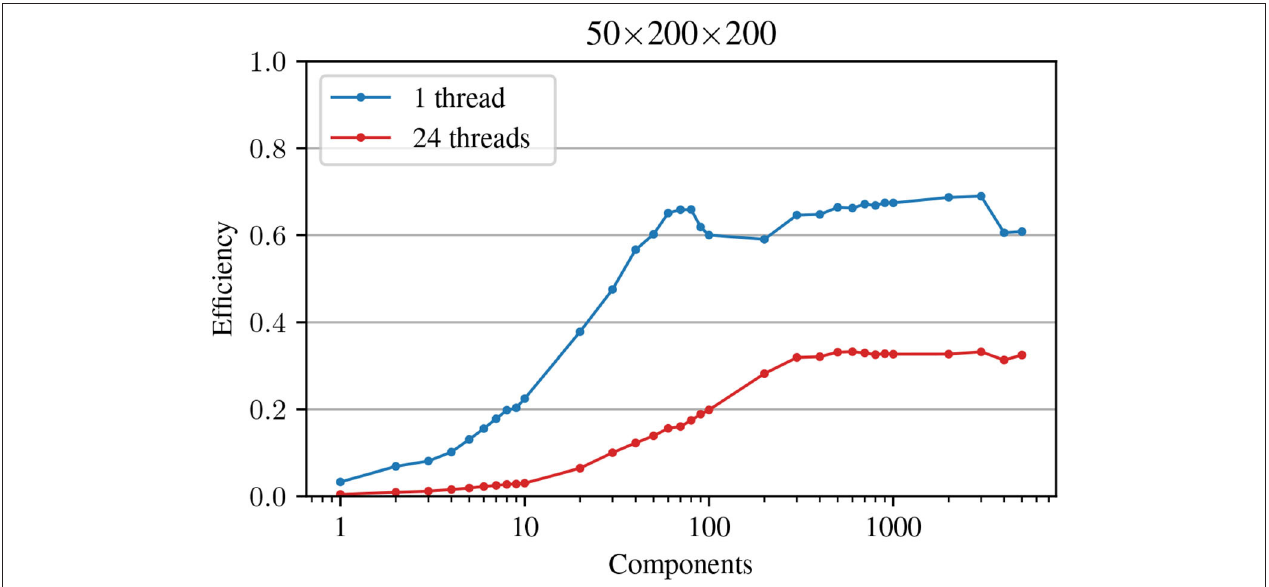
FIGURE 1 | Efficiency of MTTKRP on a 50 × 200 × 200 tensor for an increasing number of components. Note that in the multi-threaded execution, the theoretical peak performance increases while the total number of operations to be performed stays the same (as in the single-threaded case); this explains the drop in efficiency per thread.